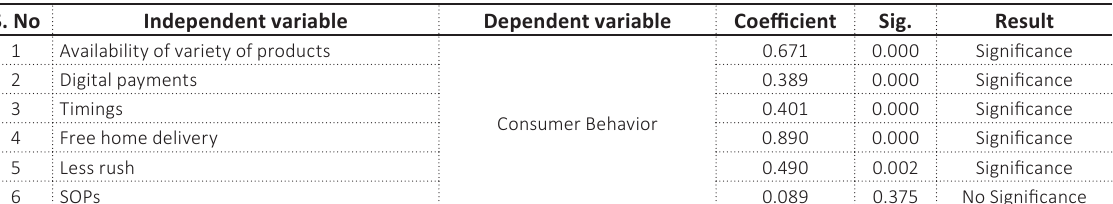
Table 6. Regression